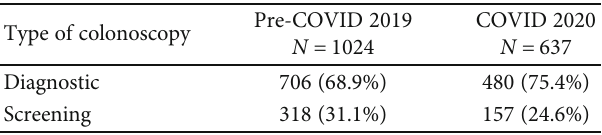
Table 1: A crosstab between diagnostic/screening colonoscopies and pre-COVID/COVID